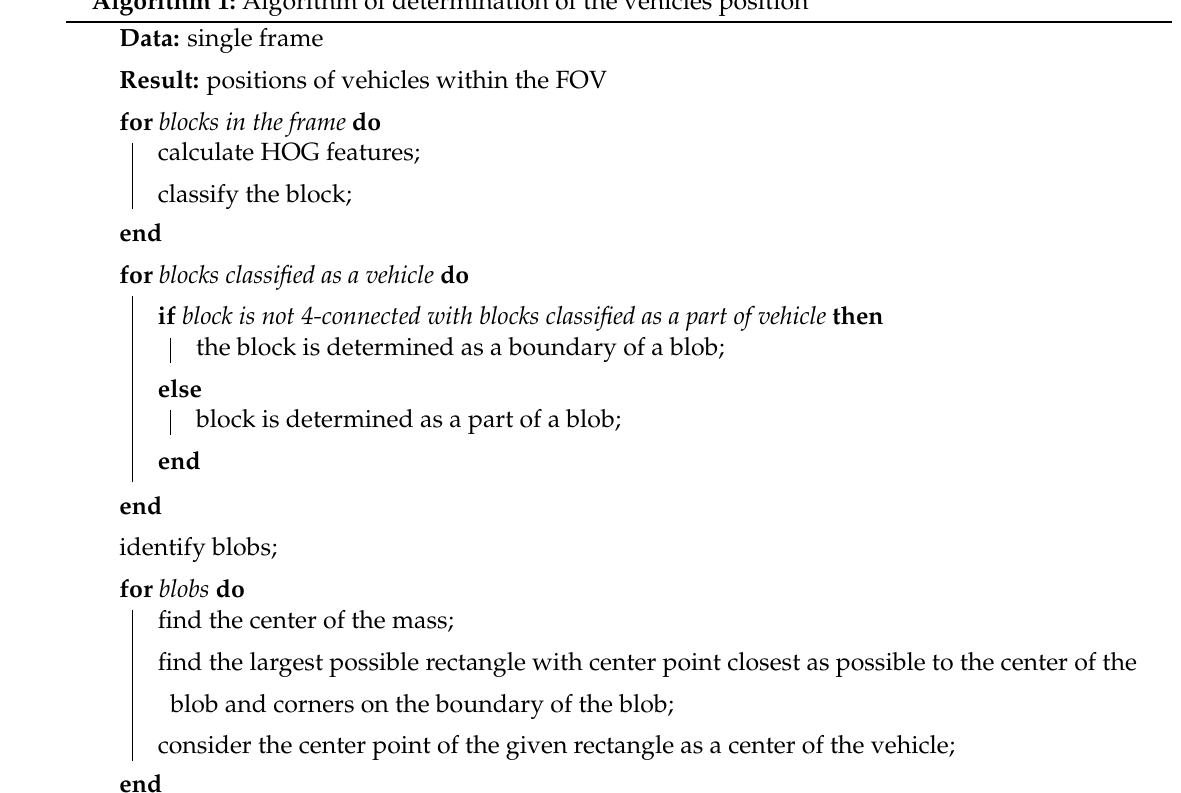
Algorithm 1: Algorithm of determination of the vehicles